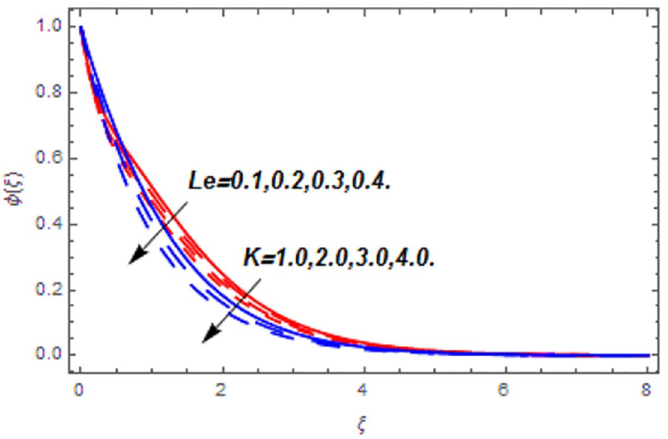
Fig 8. Concentration profiles versus Lewis number and chemical reaction parameter.